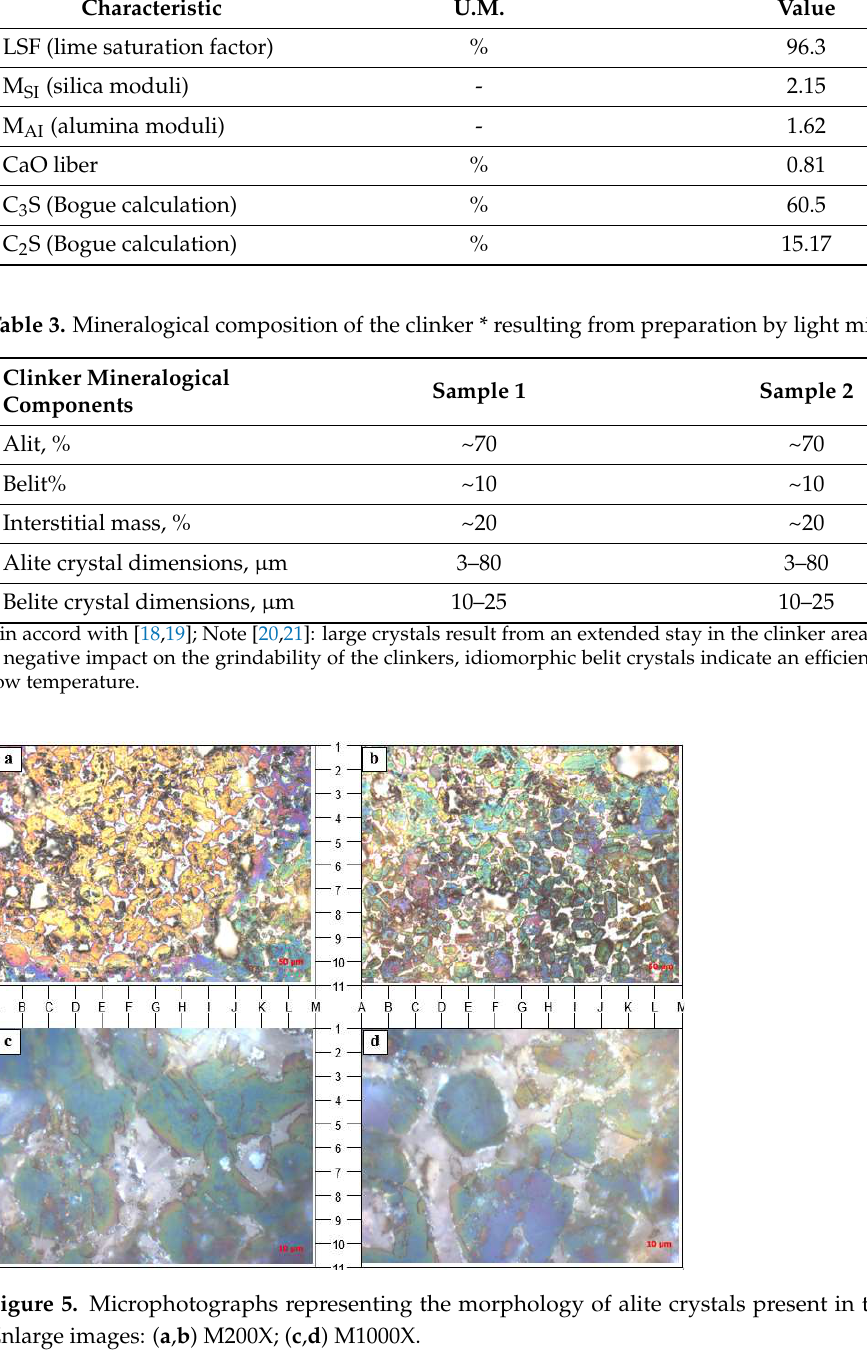
Figure 6. Microphotographs representing the morphology of the belit crystals present in the clinker nodules. Enlarge images: ( a , d ) M200X; ( b , c ) M1000X; ( d ) secondary belit for alite crystals.